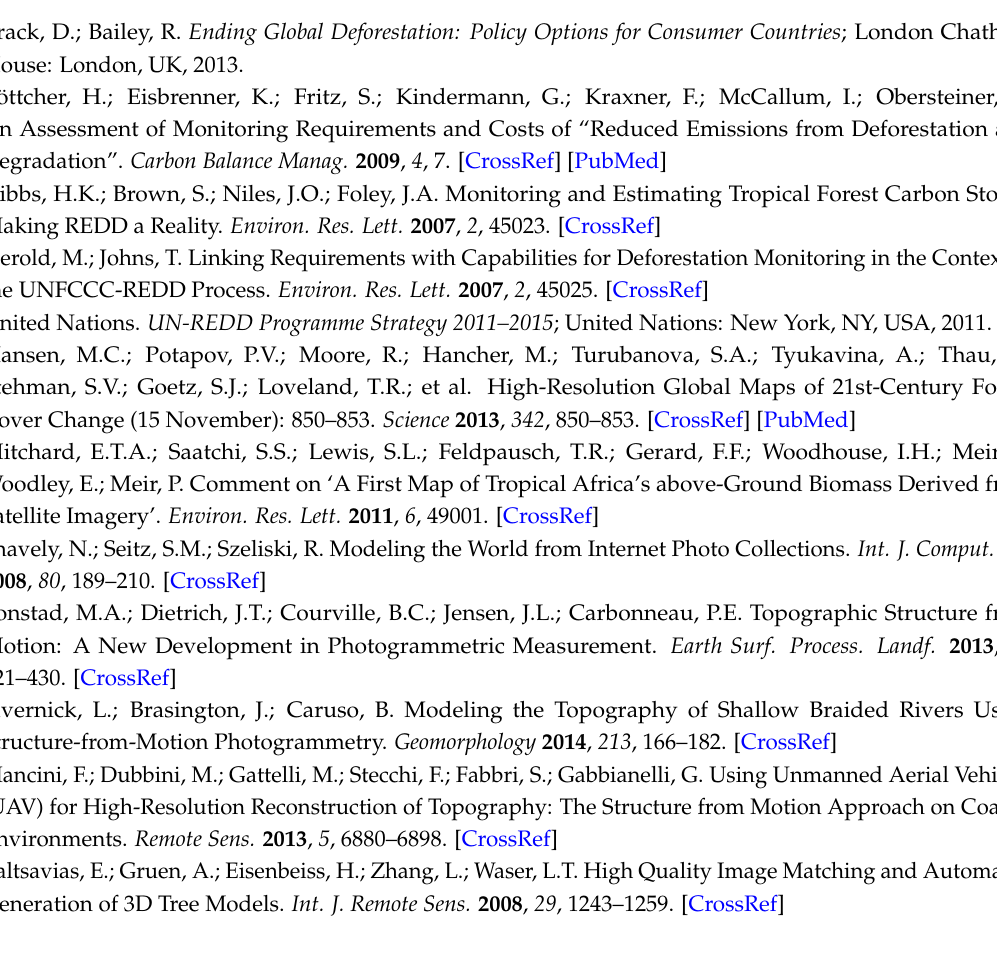
Performs poorly with poor image